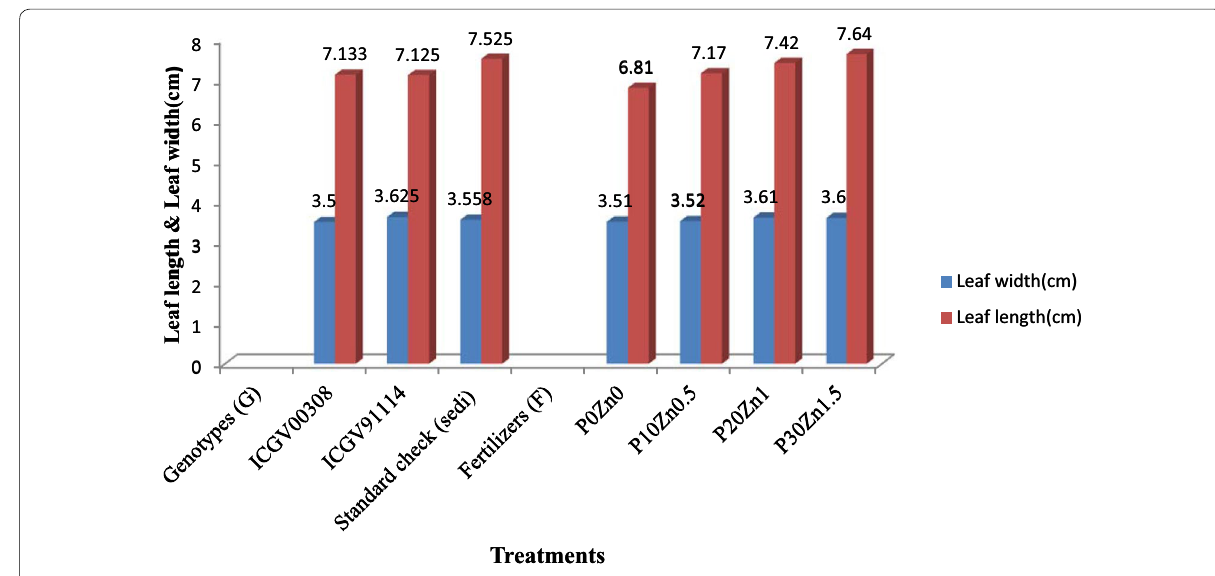
Fig. 2 Effect of genotypes and PZn fertilizers on leaf width and leaf length of groundnut